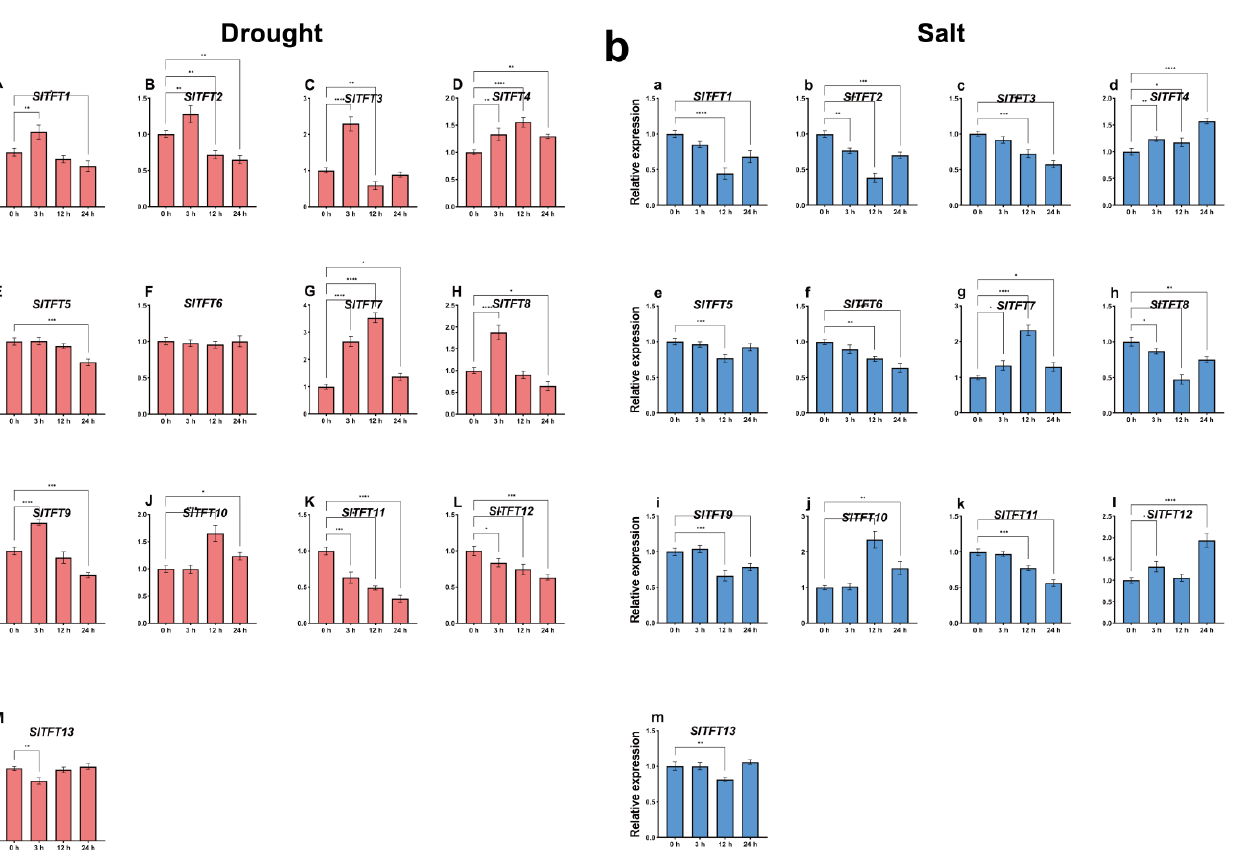
Figure 8. Responses of 13 SlTFTs to different abiotic stress salt ( a ) or drought ( b ) treatments. ( a ) A to M represent SlTFT1 to SlTFT13 , respectively. The horizontal coordinates in the figure are the four different treatment periods under 200 mM NaCl treatment, and the vertical coordinates are the relative expression of each SlTFT gene. ( b ) a to m represent SlTFT1 to SlTFT13 , respectively. The horizontal coordinates in the figure are the four different treatment periods under 300 mM D-mannitol treatment, and the vertical coordinates are the relative expression of each SlTFT gene. Error bars are the standard deviations (SD) of three independent biological replicates, presented as mean ± SD. The statistical significance of differences was confirmed by Dunnett’s multiple comparison test (* p <